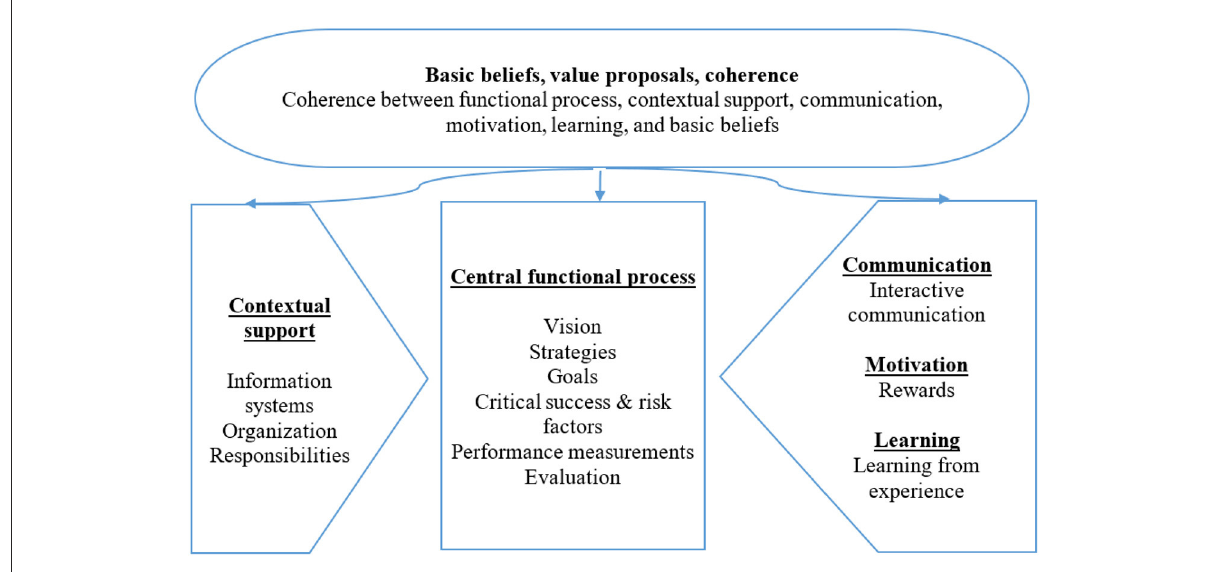
FIGURE1 A performance management framework (Johanson et al.,